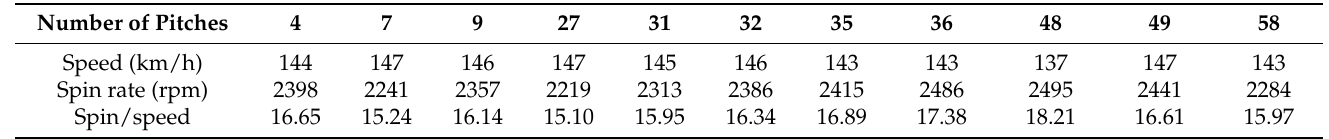
Table 4. Pitching state analysis of four-seam fastballs by Manabu Mima.